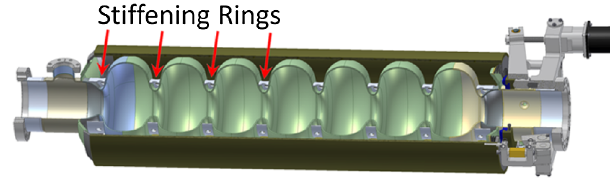
FIG. 3. Section view of a CAD model of a Cornell ERL main linac cavity. In the model shown, the cavity has stiffening rings at the same radius used in ILC